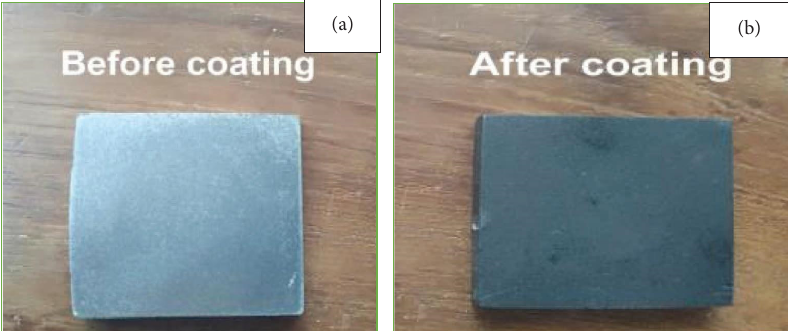
Figure 2: Alloy (a) before coating and (b) after coating.